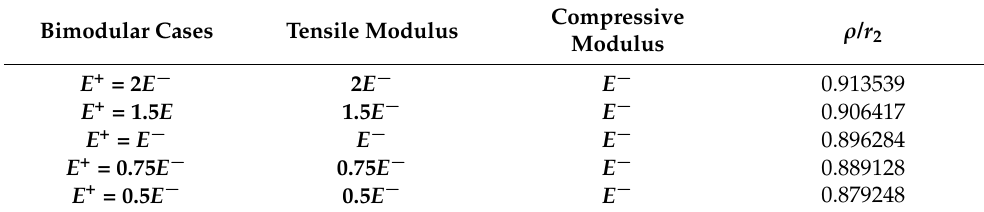
Table 1. Neutral layer positions for five bimodular cases when r 1 / r 2 =